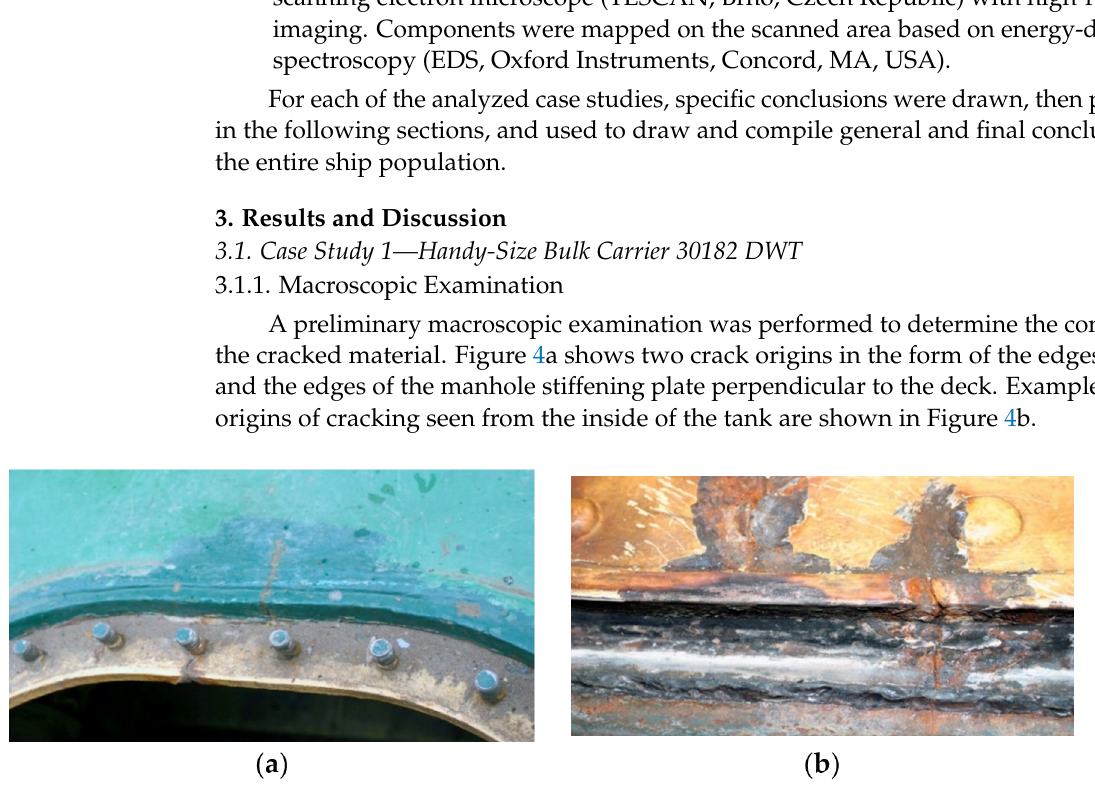
Figure 4. Pictures of origins of cracks: ( a ) view from the outside and ( b ) view from the inside of the tank (handy-size bulk carrier 30182 DWT). Macroscopic examination.